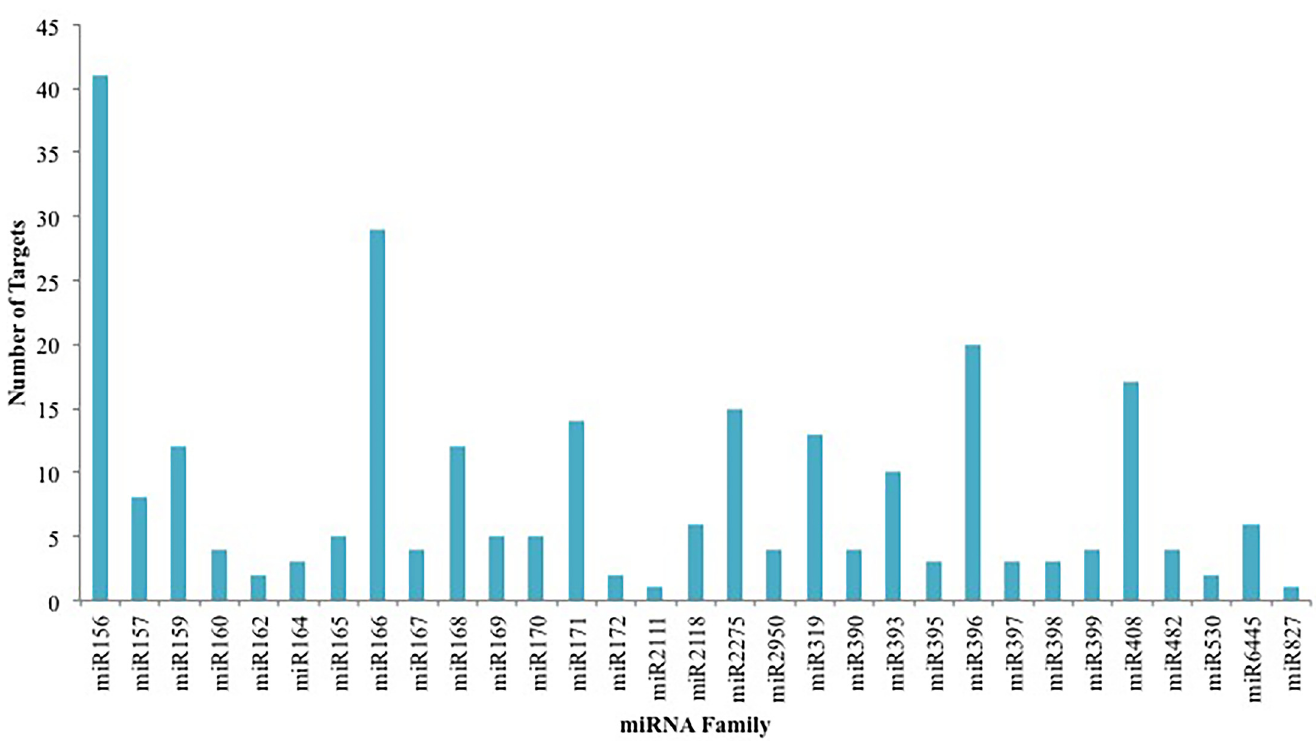
Fig 9. Number of targets predicted for each identified conserved miRNA in